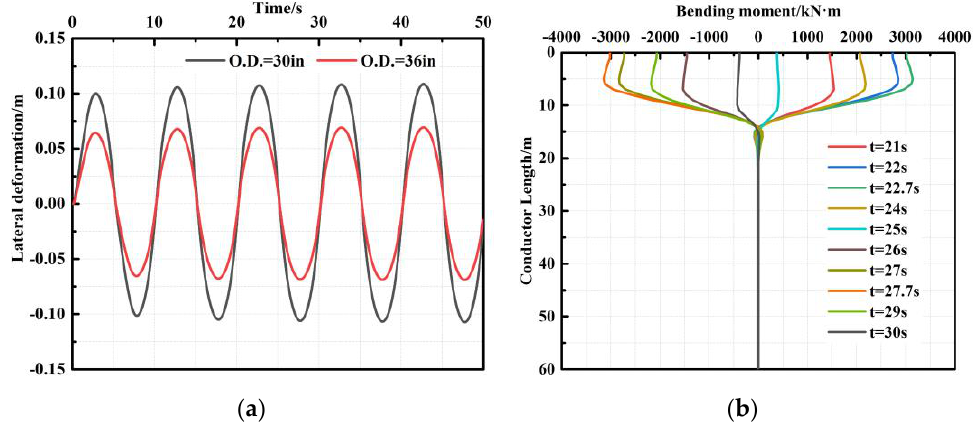
Figure 14. The influence of O.D. on the mechanical response of the conductor, where ( a ) is the variation of the lateral moment at the top of the conductor with time and ( b ) is the variation of the bending moment along the conductor axial direction when the O.D. and W.T. are 36 in and 1.0 in, respectively.